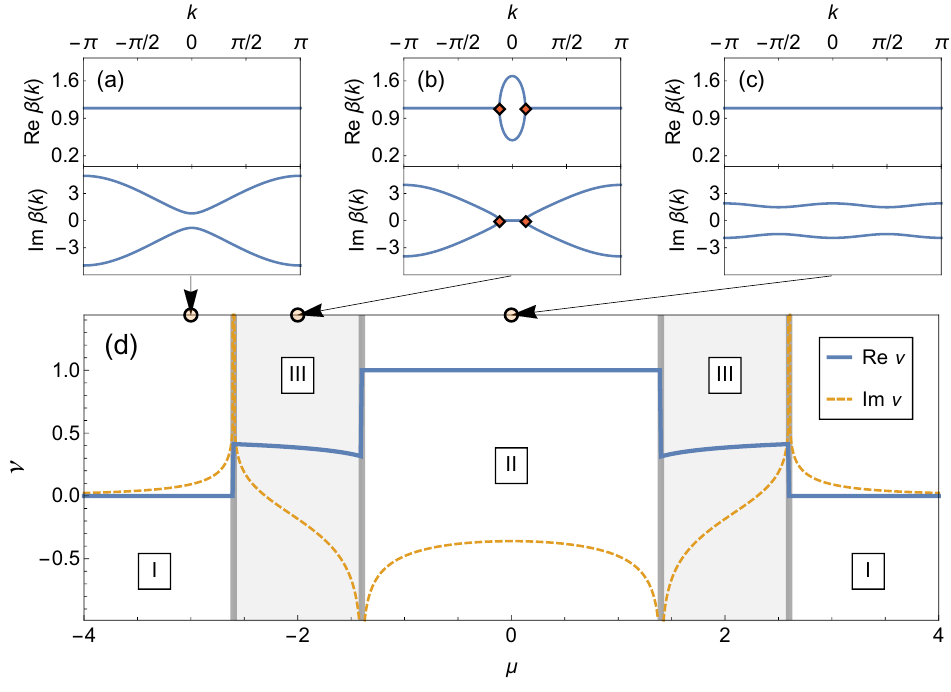
Figure 1: (a-c): The rapidity spectrum β ( k ) for three values of µ . Panel (a) at µ = − 3 and (c) at µ = 0 both show unbroken AUS. Meanwhile, panel (b) is in the AUS- broken regime, with the two exceptional points marked by red diamonds. The bottom panel (d) shows the real (blue, solid) and imaginary (orange, dashed) parts of the winding number ν of x ( k ) , with the topologically trivial phase (I), the nontrivial phase (II) and the intermediate regions (III) indicated. The other parameters are: J = 1, γ = 0.8, g = 1.0, ∆ =